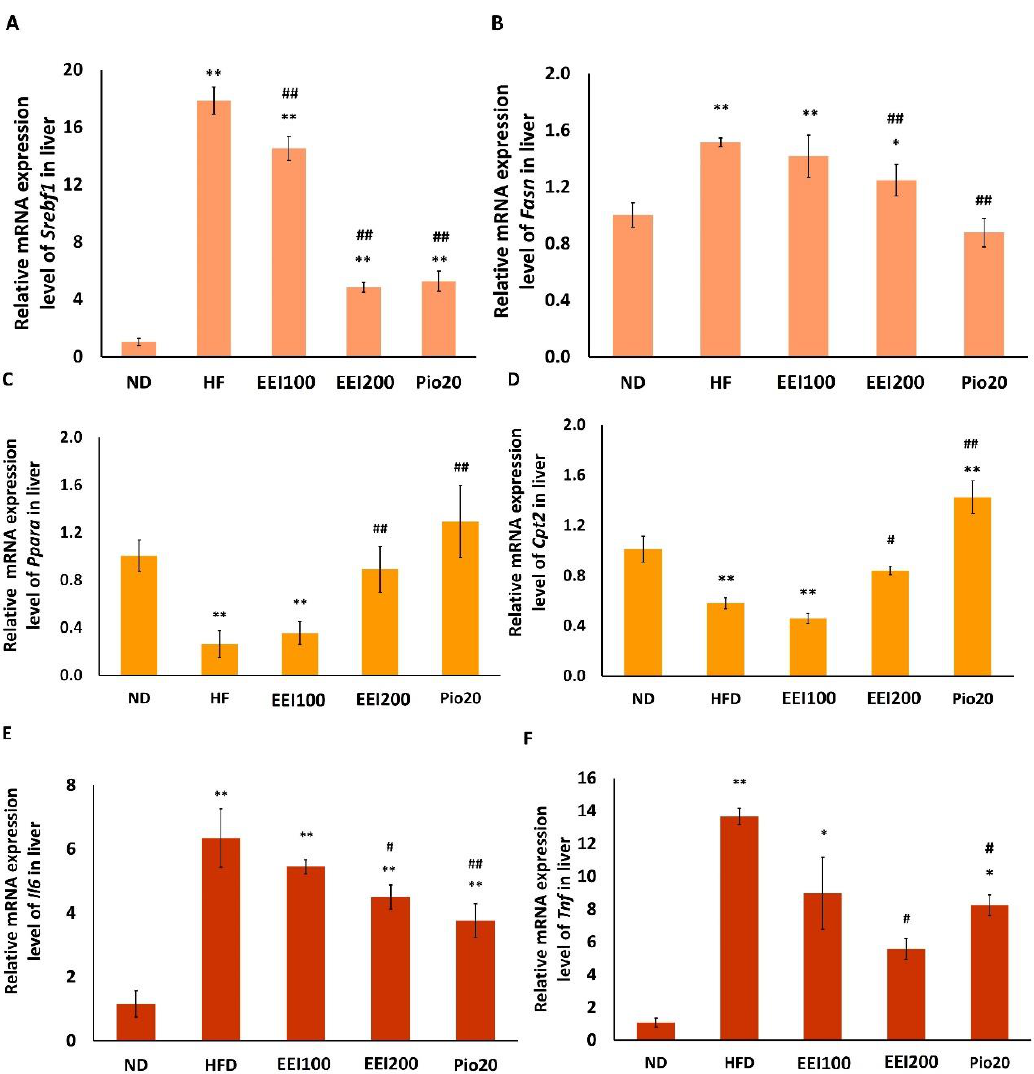
Figure 7. The effect of 2-week feeding EEI on gene expression of Srebf1 ( A ), Fasn ( B ), Ppara ( C ), Cpt2 ( D ), Il6 ( E ), Tnf ( F ) in liver. Results are presented as the means ± SEM ( n = 10). Significant differences were presented as * p < 0.05 and ** p < 0.01 compared to the ND group, # p < 0.05 and ## p < 0.01 compared to the HFD group. ND = Normal diet-fed rats treated with vehicle; HFD = High fat diet-fed rats treated with vehicle; EEI100 = HFD-fed rats treated with 100 mg/kg/day of EEI; EEI200 = HFD-fed rats treated with 200 mg/kg/day of EEI; Pio = HFD-fed rats treated with 20 mg/kg/day of pioglitazone.